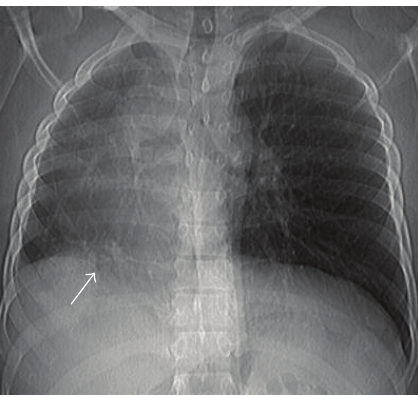
Figure 1: Chest radiograph depicts consolidation at right lower zone (white arrow) in addition to reduced right lung volume and ipsilateral shifting of cardiac shadow.